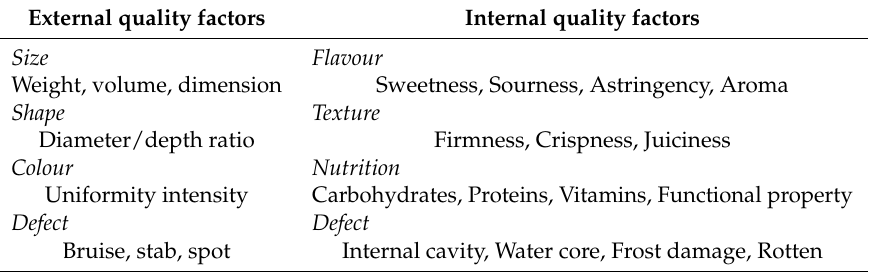
Table 1. Components of quality factors of fruits and vegetables.